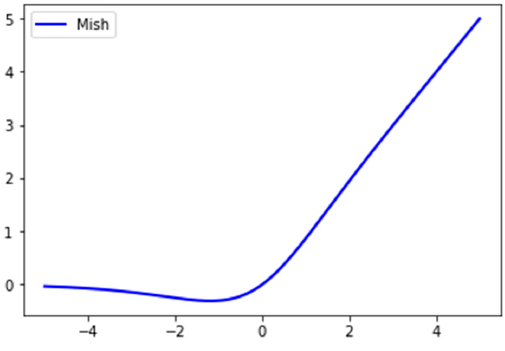
Figure 4. Curve of Mish function.